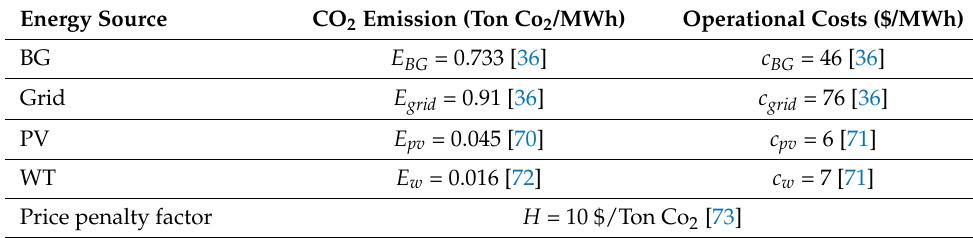
Table 1. Operational costs as well as emissions of the renewable sources and the grid. Energy